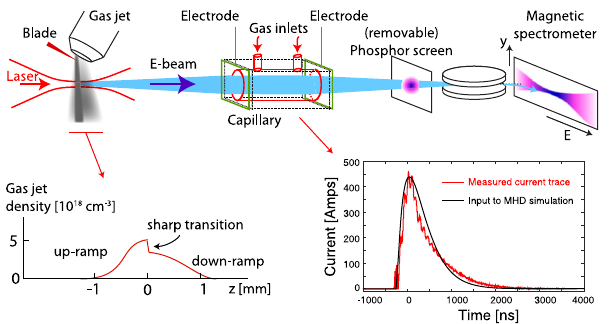
FIG. 2. Schematic concept of the experimental setup. Electron beams produced by a jet-blade assembly [35] were propagated through the plasma lens to either a transverse charge diagnostic (phosphor screen) or energy distribution diagnostic (magnetic spectrometer). The bottom left inset shows the (simplified) plasma profile at the LPA, while the bottom right inset displays the measured discharge current profile (red curve) and profile used for the MHD simulations (black curve).